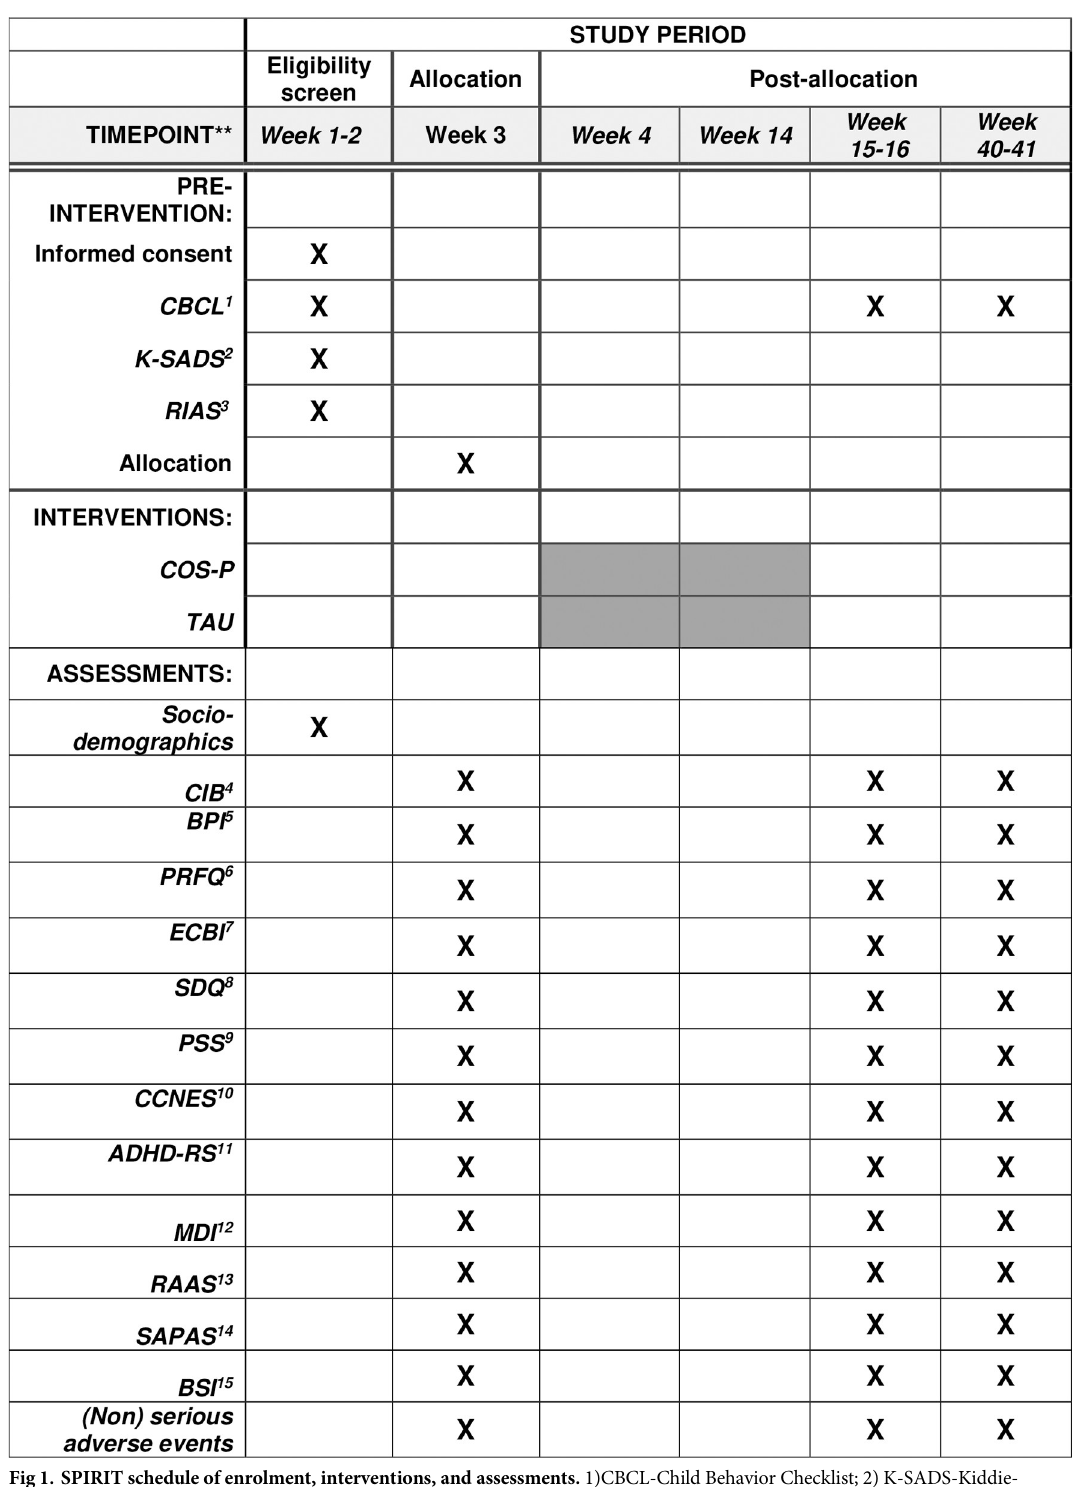
PLOS ONE | https://doi.org/10.1371/journal.pone.0265676 April 26, 2022 8 /